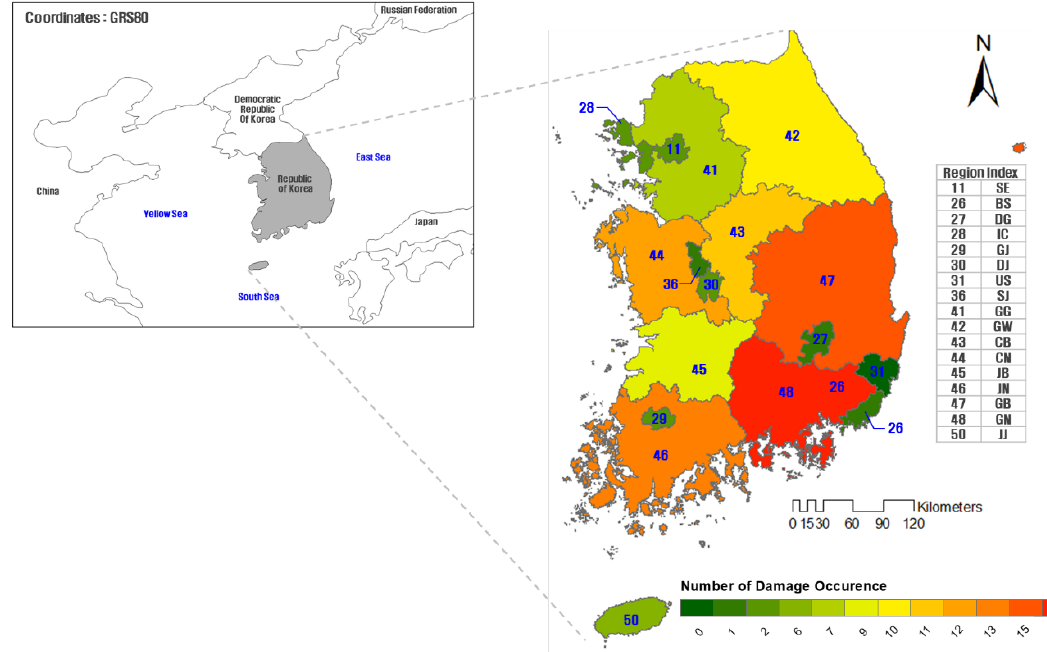
Figure 2. Damage from agricultural droughts by municipality (1965–2018).